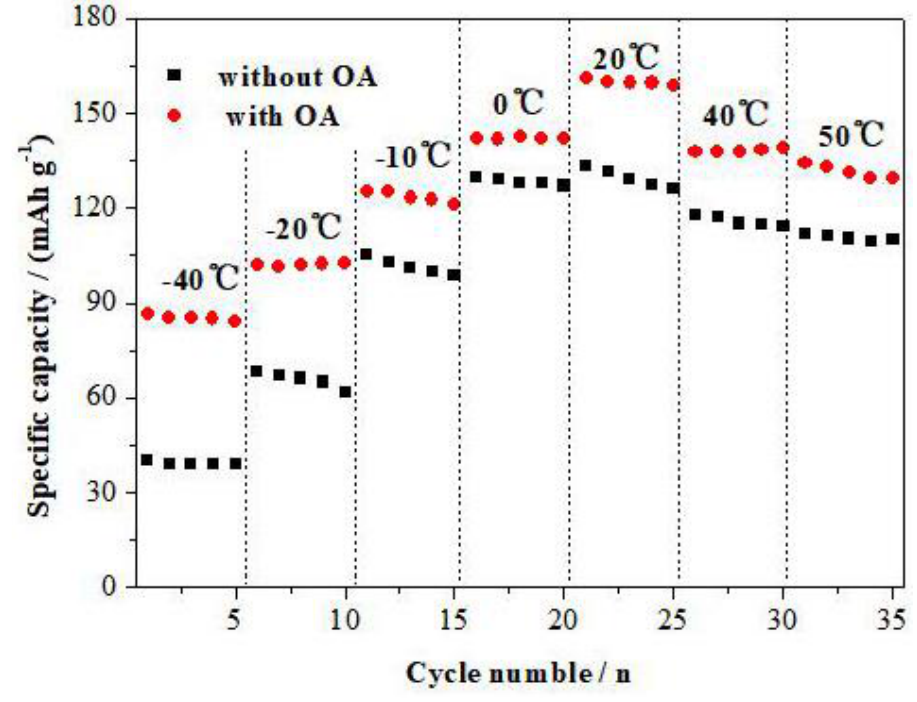
Figure 5. Effect of temperature on the specific capacity of LiFePO 4 electrodes prepared.